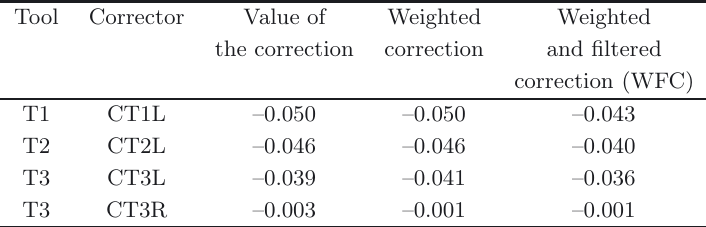
Table 12. Proposed